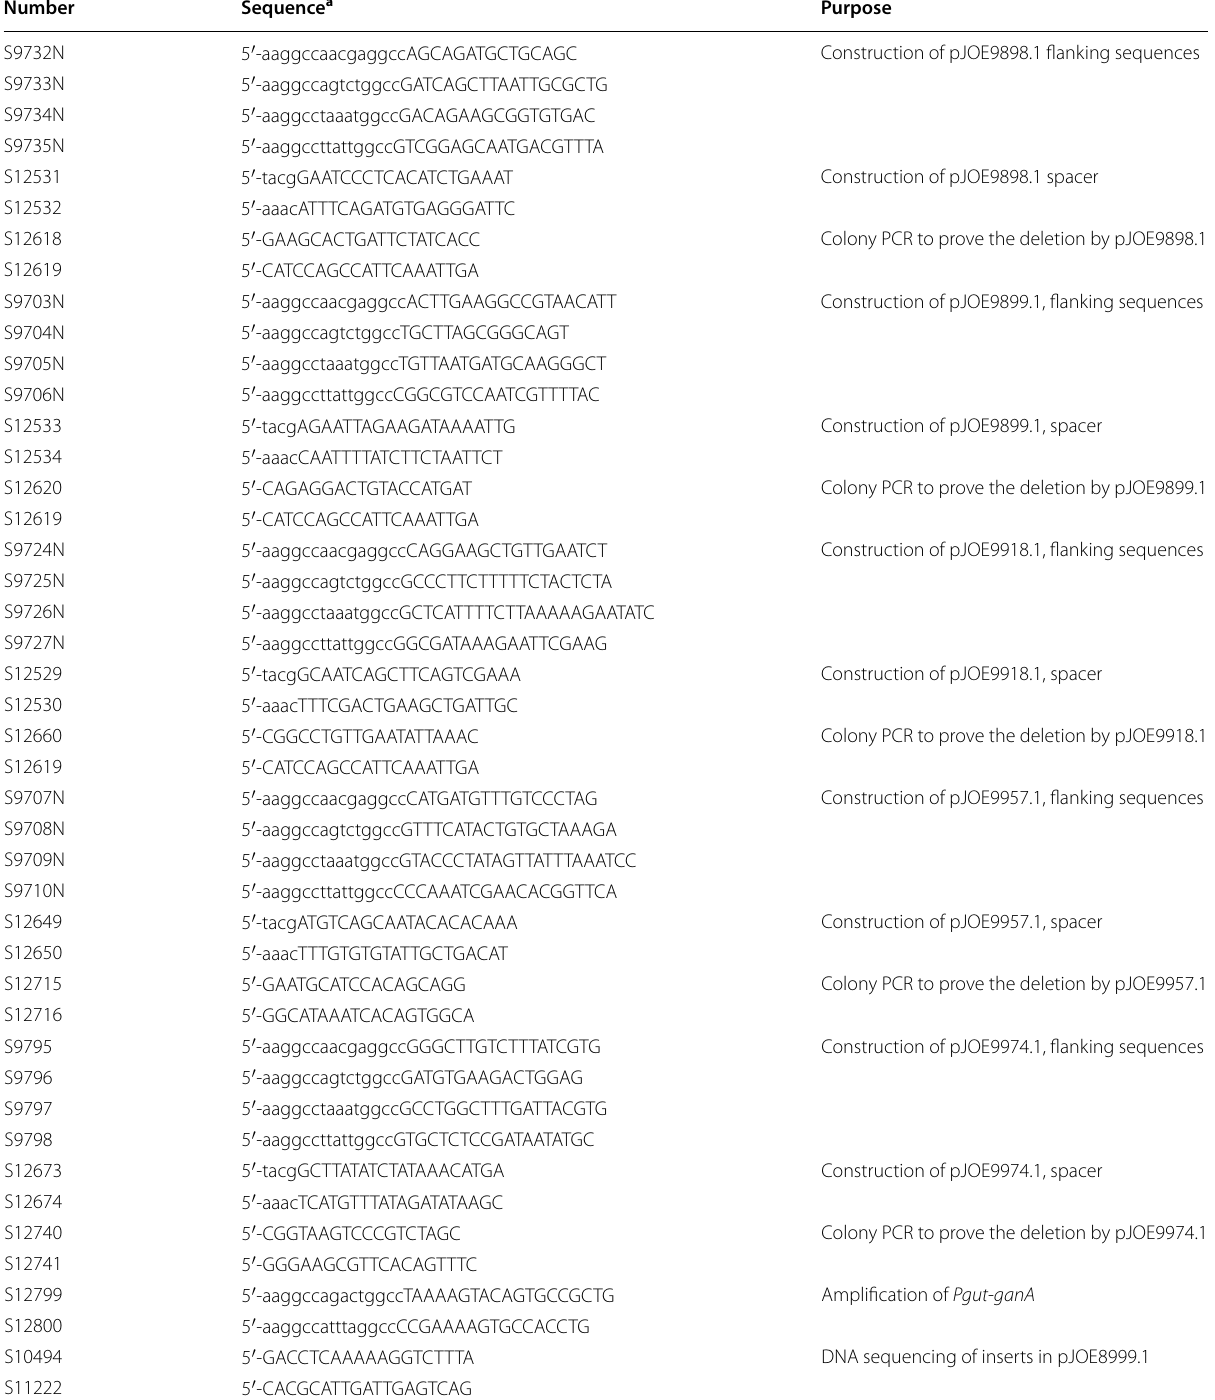
a Small letters: nucleotides added for